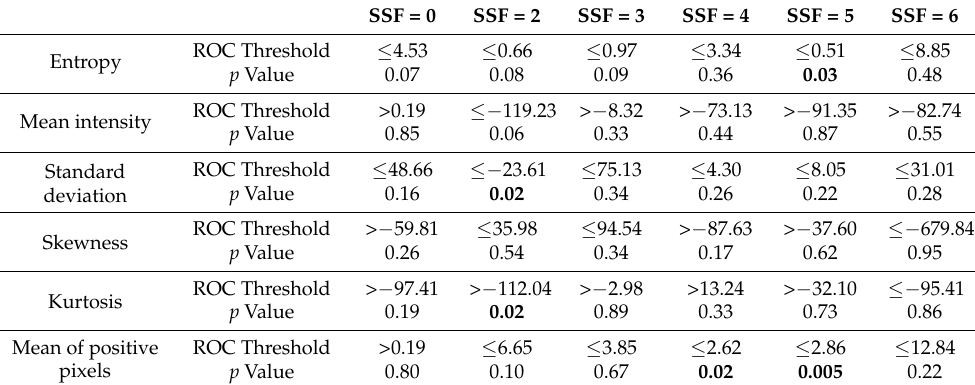
Table 6. ROC and Kaplan-Meier analysis for percentage change in texture parameters at different scale values.